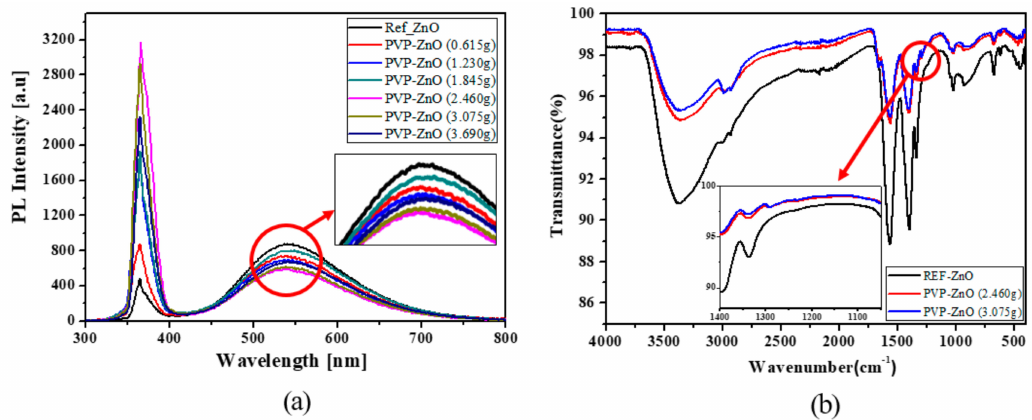
Figure 2. ( a ) Photoluminescence (PL) spectra of PVP-ZnO NPs (0.615 g, 1.230 g, 1.845 g, 2.460 g, 3.075 g, and 3.690 g) and Ref-ZnO, ( b ) FT-IR spectra of PVP-ZnO NPs (2.460 g and 3.075 g) and Ref-ZnO.